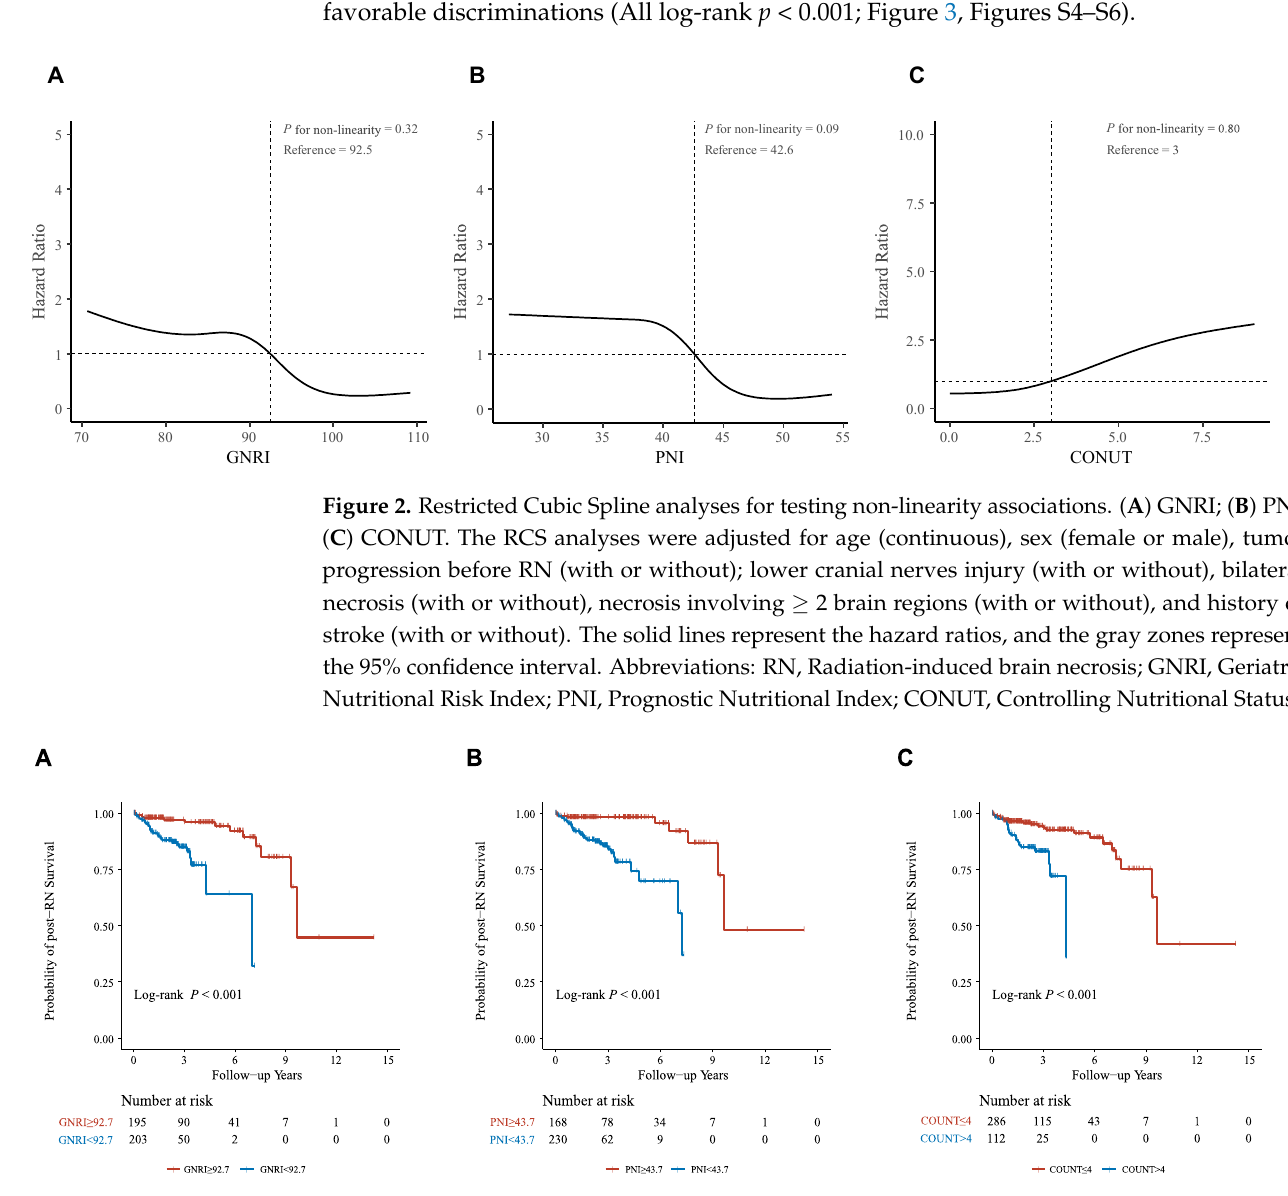
Figure 3. Nutritional risk stratifications and post-RN survival. ( A ) GNRI; ( B ) PNI; ( C ) CONUT. Abbreviations: GNRI, Geriatric Nutritional Risk Index; PNI, Prognostic Nutritional Index; CONUT, Controlling Nutritional Status.